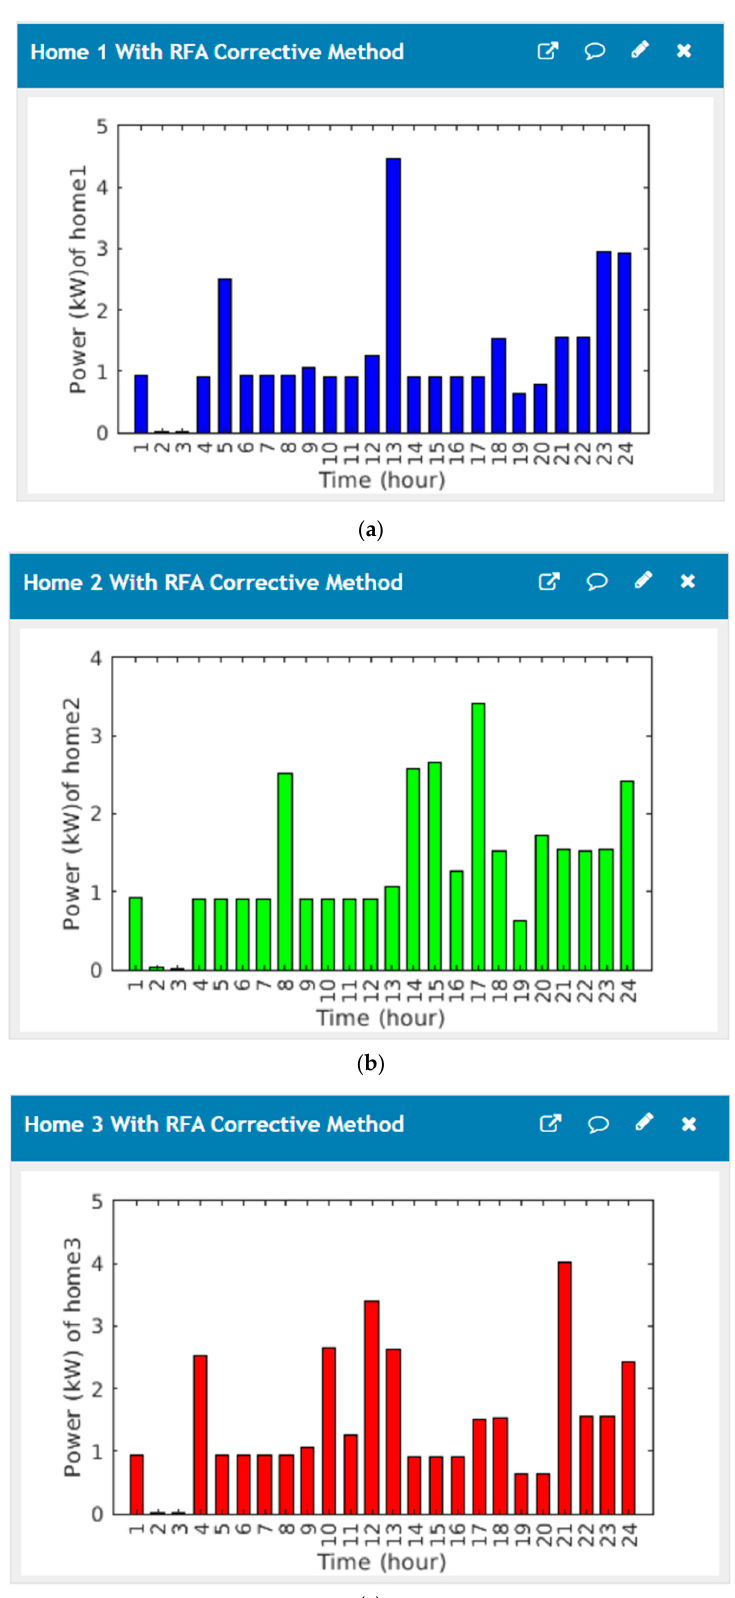
Figure 10. Power GUI of the proposed system after implementing the SSA algorithm: ( a ) load pro-